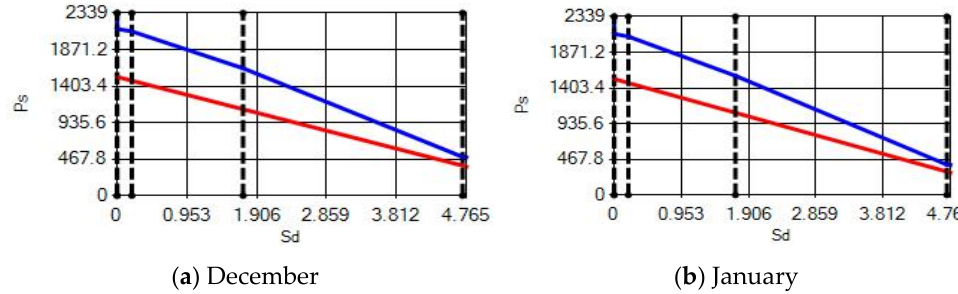
Figure 25. Condensation and evaporation amount chart in the building elements of the pumice external wall for the 4th zone for ( a ) December and ( b ) January.